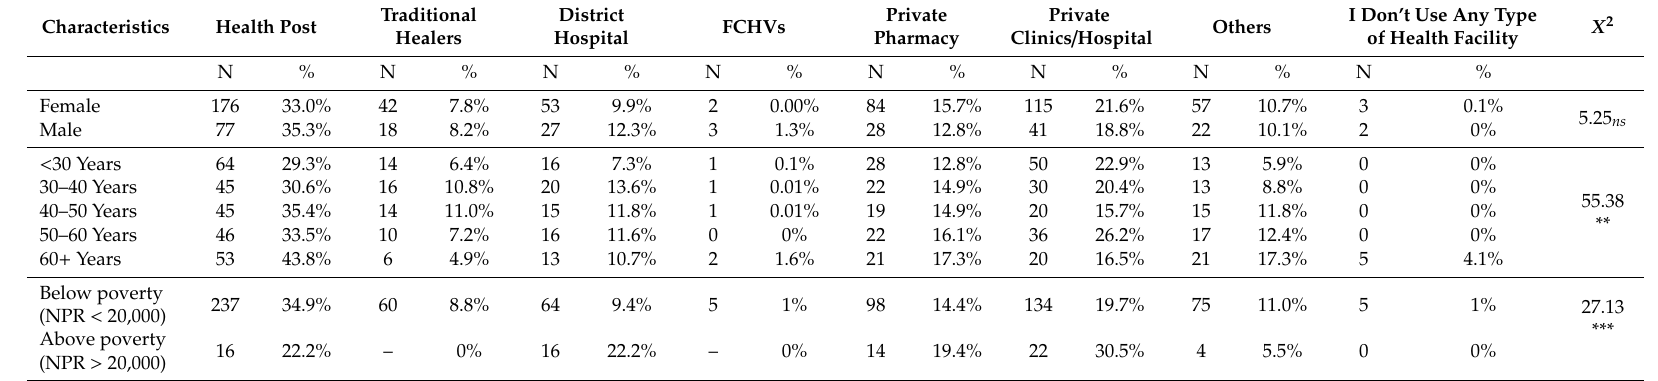
Table 4. Demographic di ff erences between healthcare